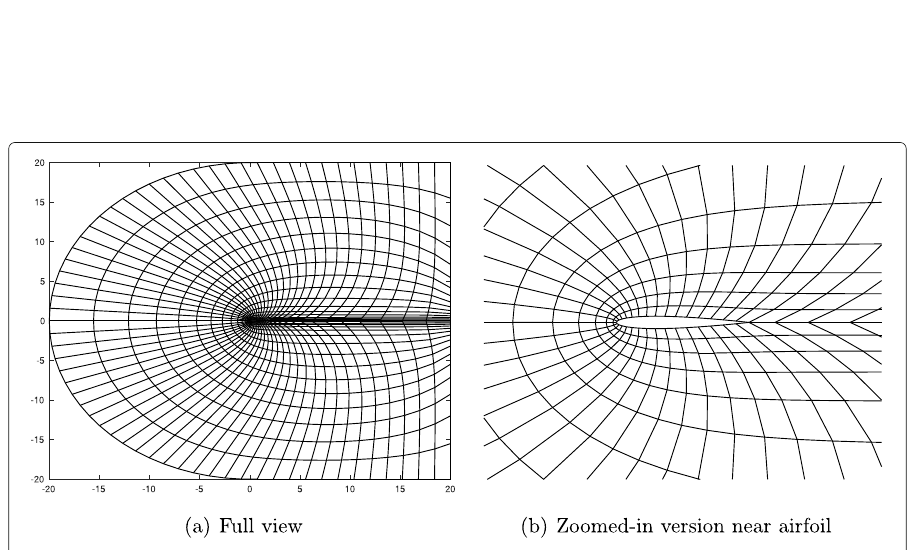
Fig. 9 Background mesh for NACA0012